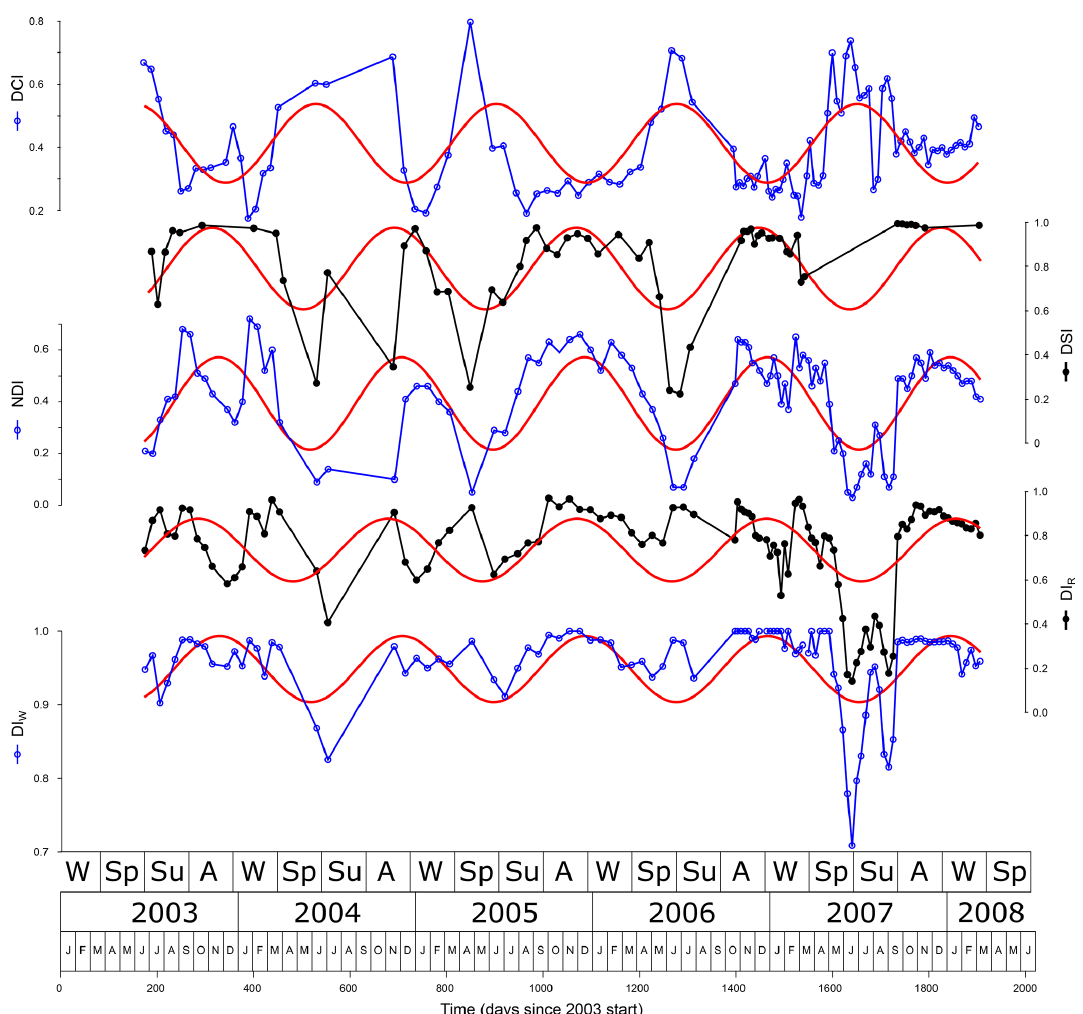
Figure 5. Diol proxies and their main (annual) frequency component. Note the close similarities between the diol proxies and the DCI behaving opposite to the